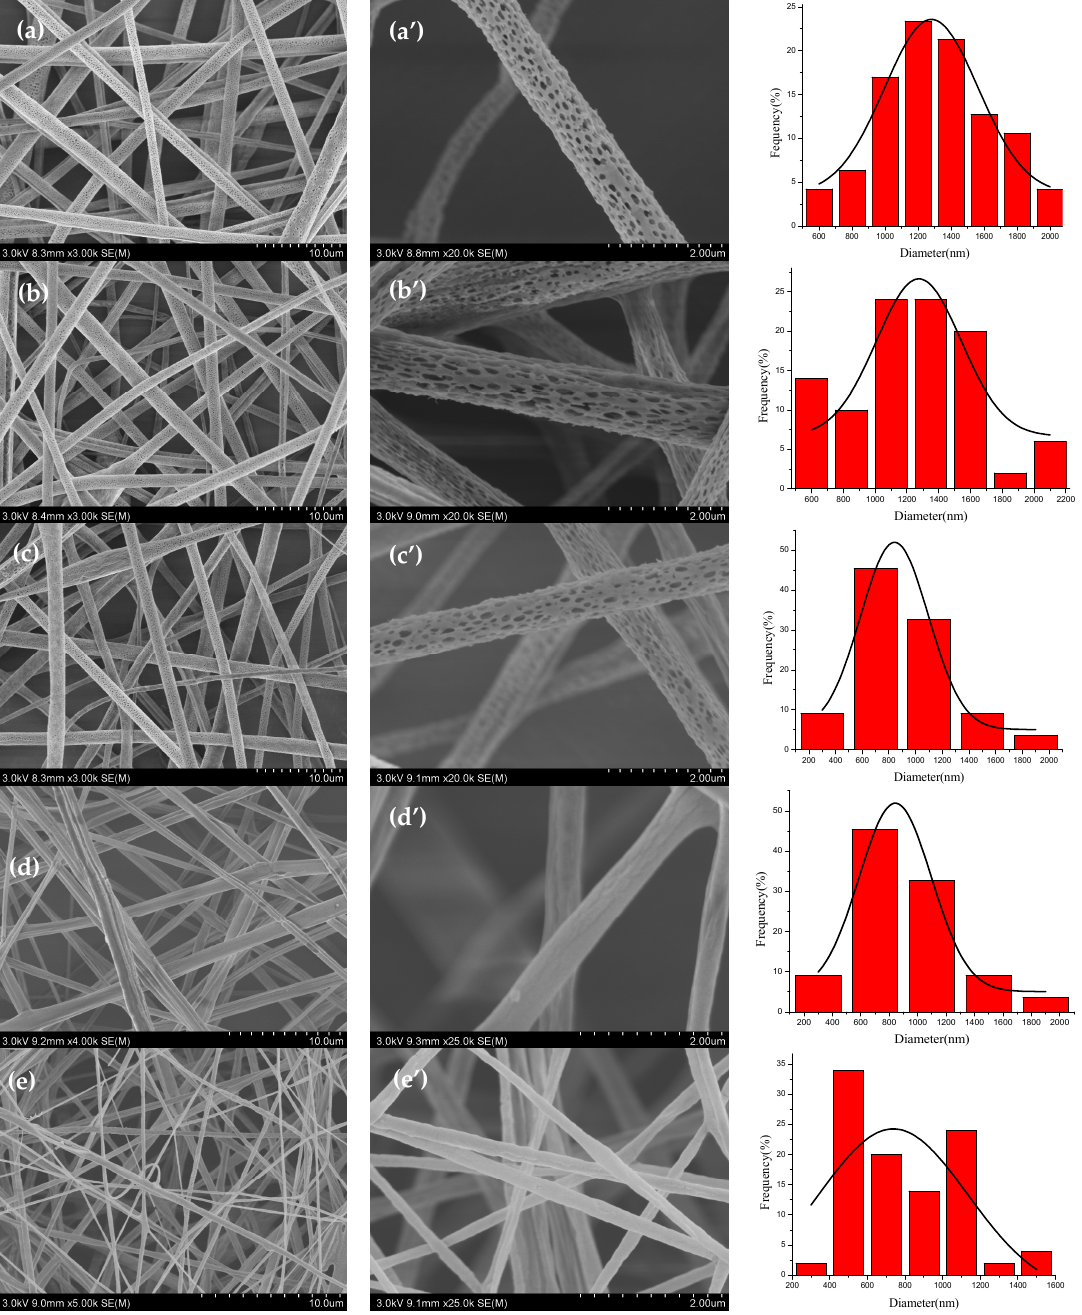
Figure 2. SEM pictures of tea polyphenol (TPP) loaded porous core-shell fibers with the weight ratio 9:1 at core solution flow rates of ( a , a’ ) 0.05 mL/h; ( b , b’ ) 0.1 mL/h; and ( c , c’ ) 0.2 mL/h, respectively, and nonporous core-shell fibers at core solution flow rates of 0.2 mL/h with the weight ratio (DCM/DMF) ( d , d’ ) 7:3 and ( e , e’ ) 5:5. The rightmost figures were the according diameter distribution. Table 1. Average diameters of TPP loaded core-shell nanofibers.